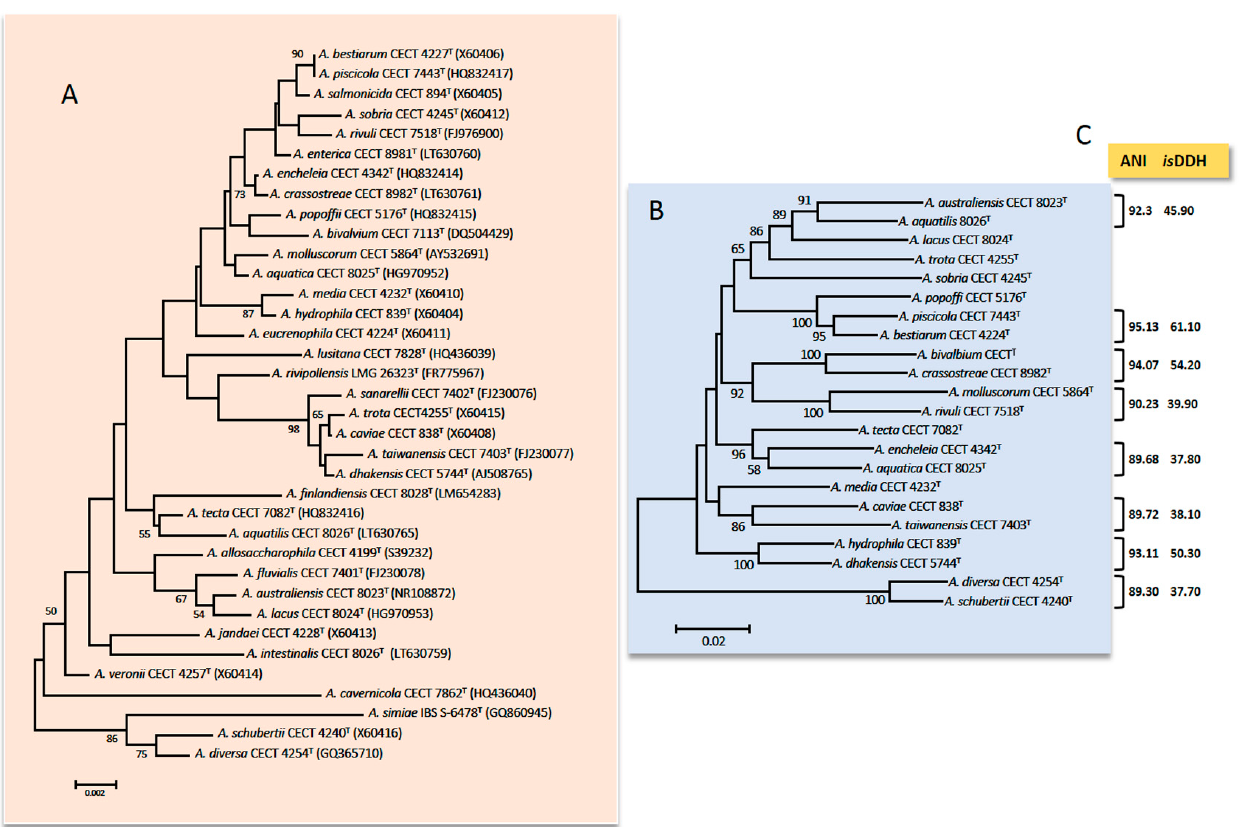
Figure 1. ( A ) Phylogenetic tree based on the sequences of the 16S rRNA gene (1498 bp) among 36 species of Aeromonas. ( B ) Phylogenetic tree based on the concatenated sequences of rpoD and gyrB genes (1098) among the most similar species based on the 16S rRNA gene. The number in the nodes indicates the bootstrap values substitutions estimated by site. ( C ) Results (%) for the ANI (average nucleotide identity) and is DDH ( in silico DNA–DNA hybridization) obtained between the genomes of the most similar species; notice that ANI and is DDH values are ≤ 96% and ≤ 70% in all cases, respectively which are the cut-off values established for delimiting Aeromonas spp.